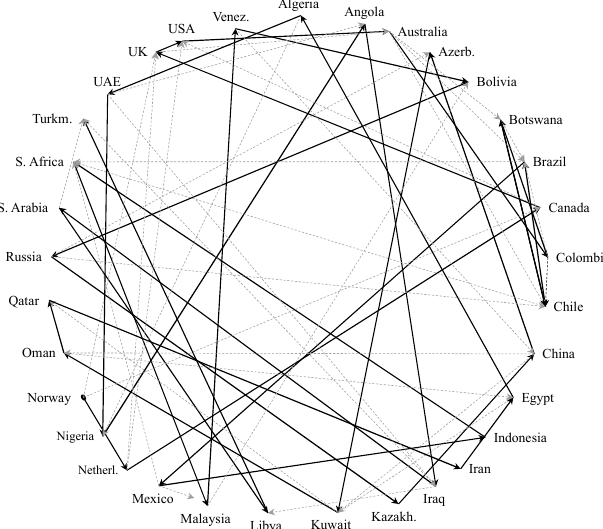
Figure 2. Visual representation of steps in manual calculation of segmented string relative ranking (SSRR) of public brainpower (solid lines = final ranking; dotted lines = other relationships that were checked).